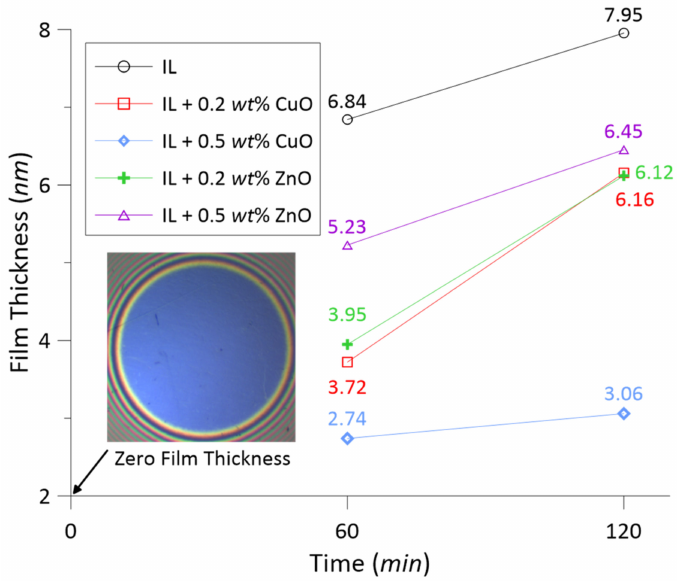
Figure 6. Measured film thickness at wear track on the ball.